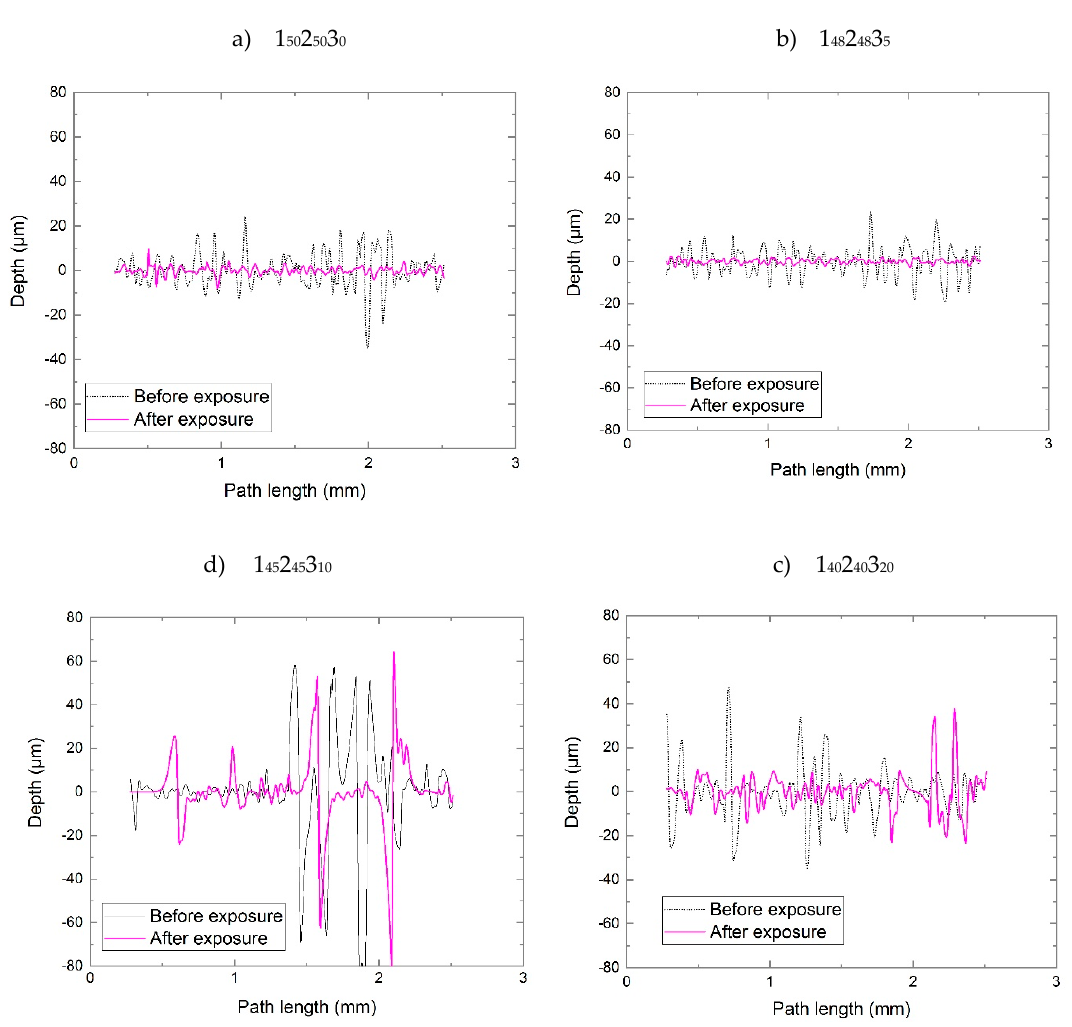
Figure 8. Roughness topographic analysis of virgin cured laminates as a function of POSS content: ( a ) 0%, ( b ) 5%, ( c ) 10%, ( d ) 20% and after 12 months of exposure in simulated LEO.